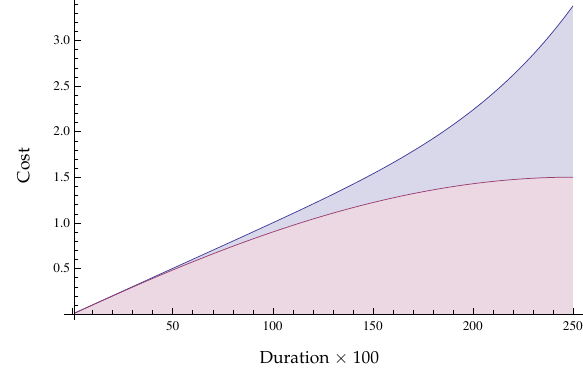
Figure 7. Cost Linear(r) (Violet) and Cost OFFLINE